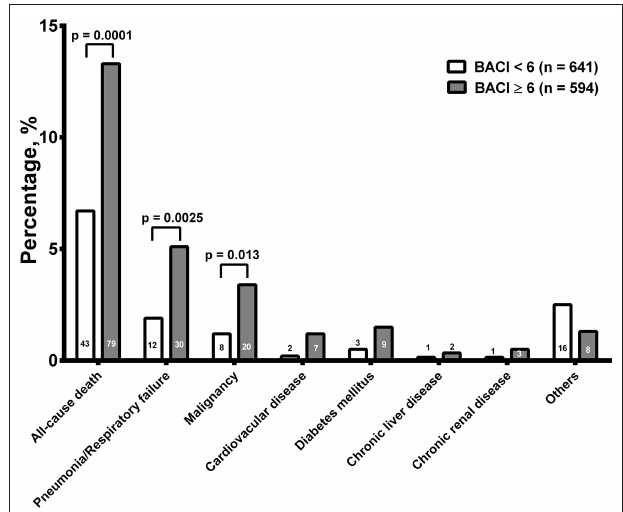
FIGURE 3 | The overall mortality from hospitalization to a 1-year follow-up. The numbers of death and significance are indicated. BACI, bronchiectasis etiology comorbidity